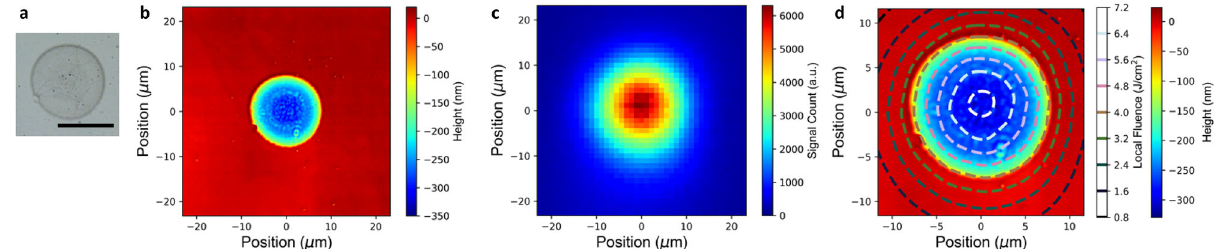
Fig. 2 Correlation procedure of the ablated crater and beam pro fi le with sapphire. Data correspond to ablation with a single 1028 nm, 190 fs pulse at 30 μ J. a Optical microscope image of the ablated crater. The scale bar corresponds to 10 μ m. b The corresponding height pro fi le of the ablated crater obtained from a laser scanning microscope measurement. c The beam pro fi le of the ablating pulse measured in situ at the focus. d The spatially superimposed spline interpolated beam pro fi le and height, with the beam intensities displayed as contour lines. The units for the beam intensity are also converted to fl